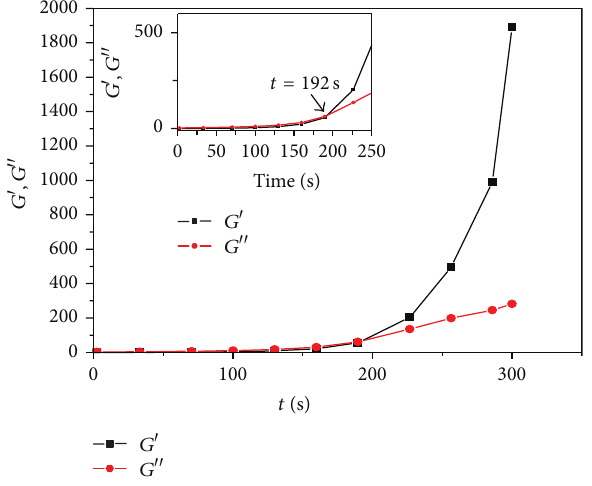
Figure 7: Variation in time of G 󸀠 and G 󸀠󸀠 for a representative sample of ureasil-PPO or ureasil-PEO, produced with HCl as catalyst agent.